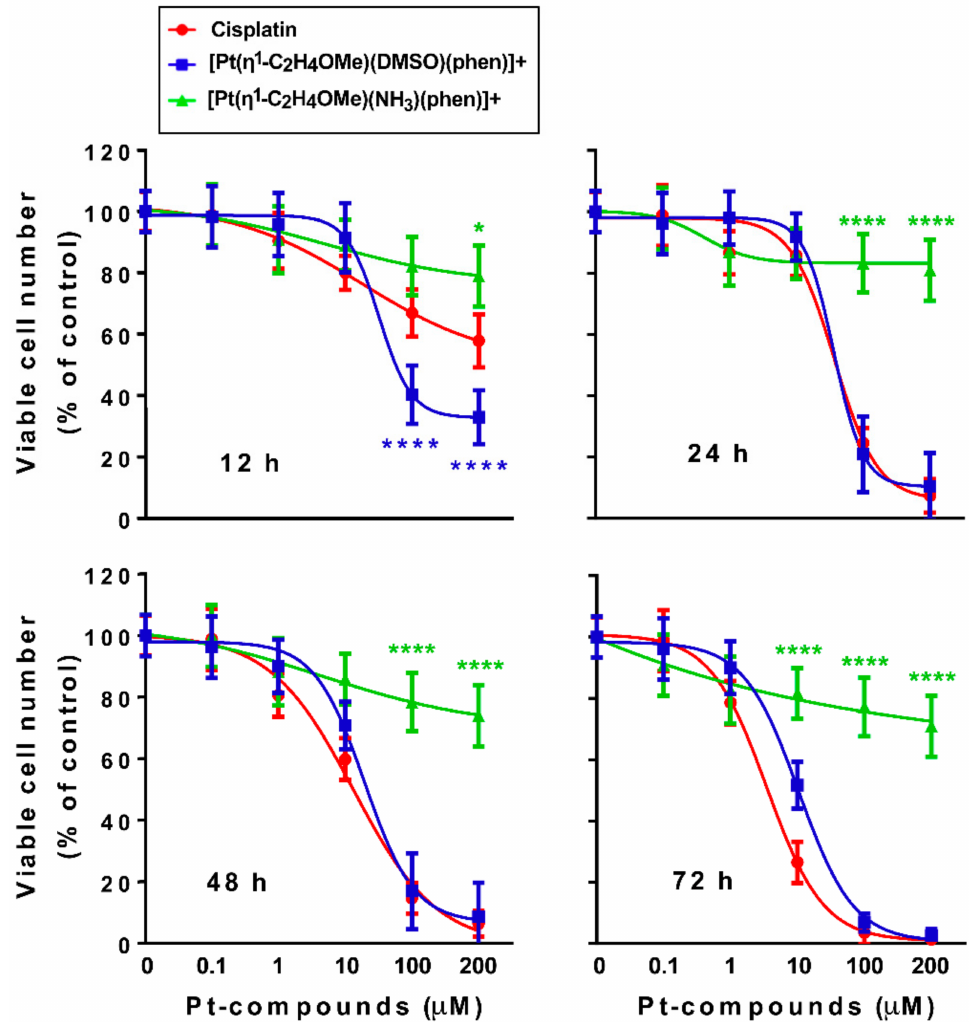
Figure 4. Cell viability assay after [Pt( η 1 -C 2 H 4 OMe)(DMSO)(phen)] + , [Pt( η 1 - C 2 H 4 OMe)(NH 3 )(phen)] + , and cisplatin treatments in SH-SY5Y cell line. The viability of the neuroblastoma cell line was evaluated after treatment with Pt compounds at different concentrations (0.1, 1, 10, 100, and 200 µ M) for 12, 24, 48, and 72 h. The data are means ± S.D. of three different experiments run in eight replicates and are presented as percent of control. Asterisks indicate values that are significantly different (* p < 0.05; **** p < 0.0001) from those of cisplatin at the same concentrations and time